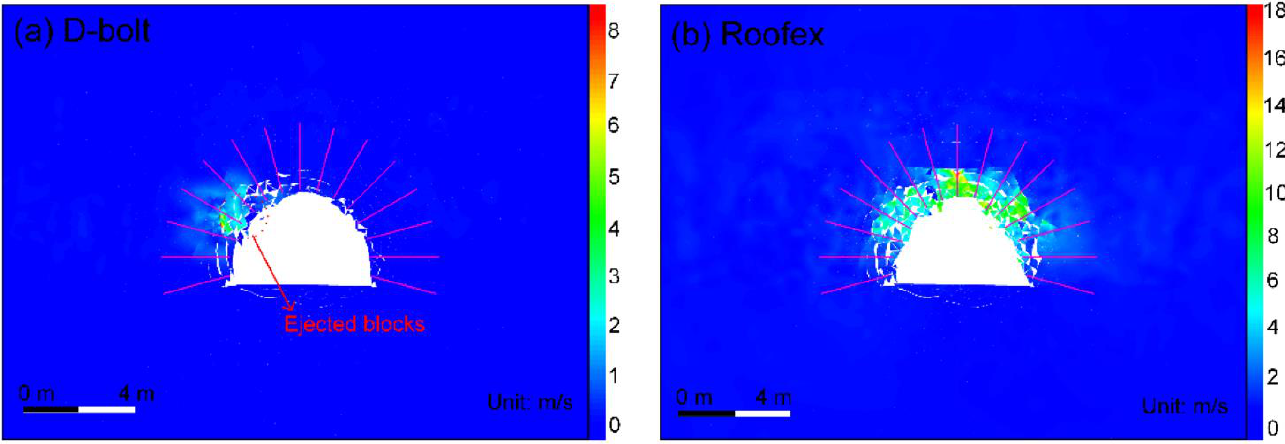
Figure 16. The contour of the displacement magnitude excavated in the rock salt chamber.